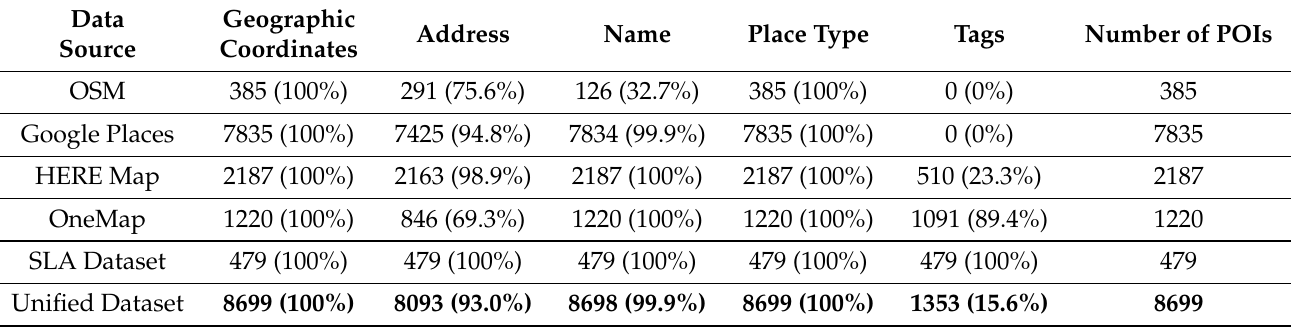
Table 4. The data coverage and completeness of each data source, including the unified dataset, is calculated based on their geographic coordinates, address, location name, place type, tags, and number of POIs obtained from the study area. A percentage value is provided to reflect the fraction of POIs that contains a particular attribute within each data